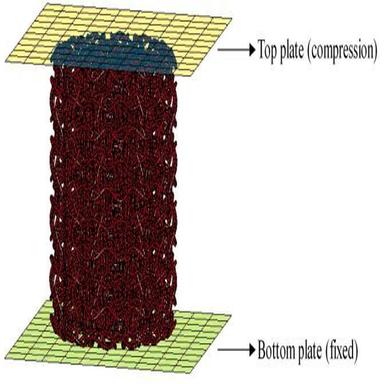
ACS computational model.